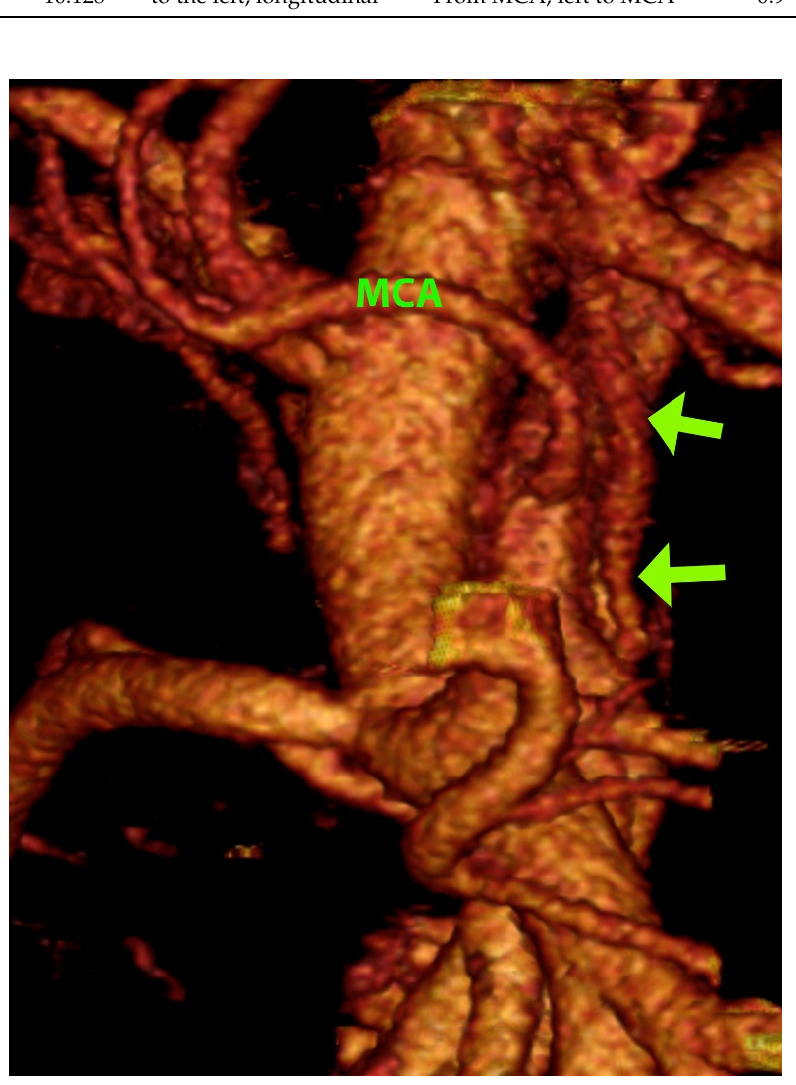
Figure 2. Three-dimensional volume rendering of the D3 volume. MCA—middle colic artery, arrows—largest lymph vessel found (caliber 3.10 mm).